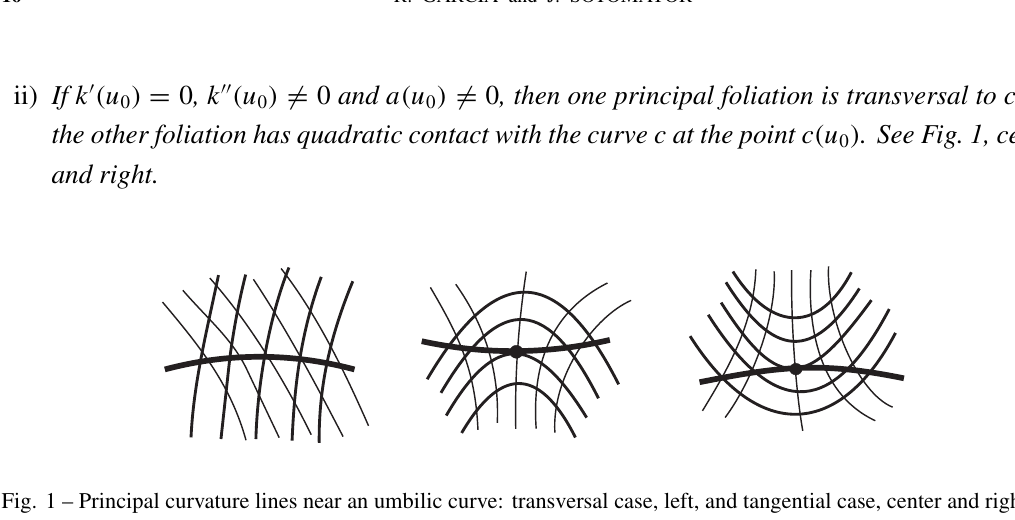
Fig. 1 – Principal curvature lines near an umbilic curve: transversal case, left, and tangential case, center and